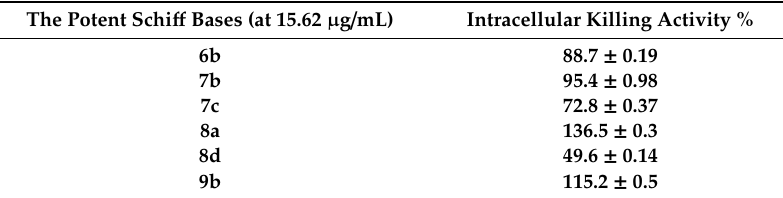
Table 5. Intracellular killing activities of Schi ff bases.